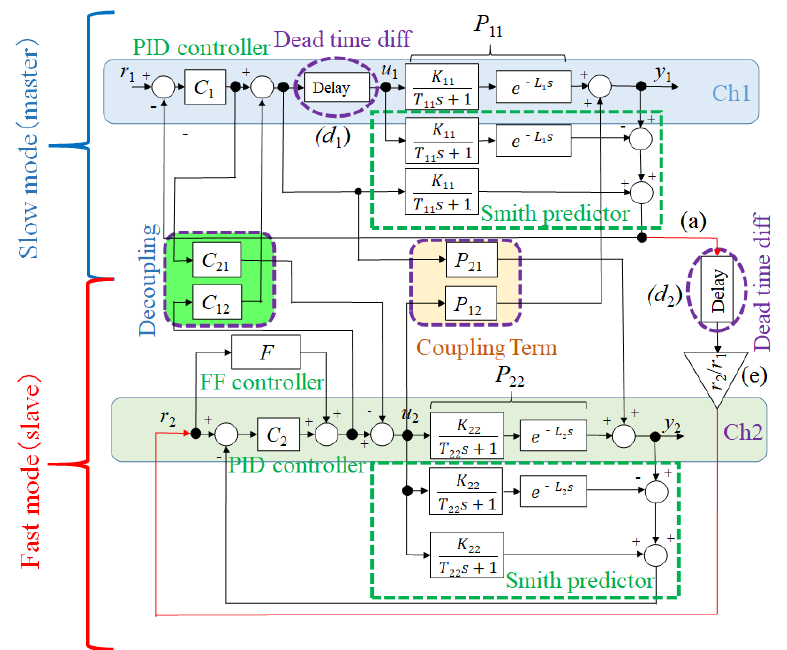
Figure 2. Overview of SMBC